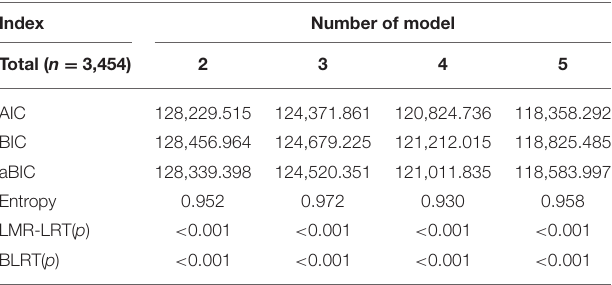
TABLE 1 | Latent profile classification of the perceived social support of the overall